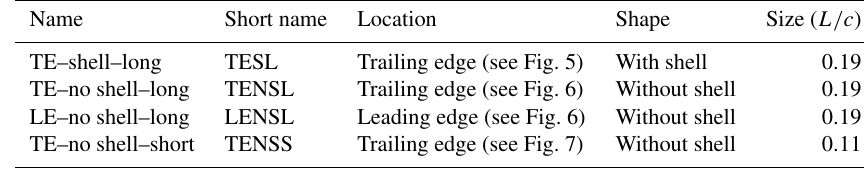
Table 1. e-TellTale configurations (with L the length of the silicon strip and c the chord of the profile).